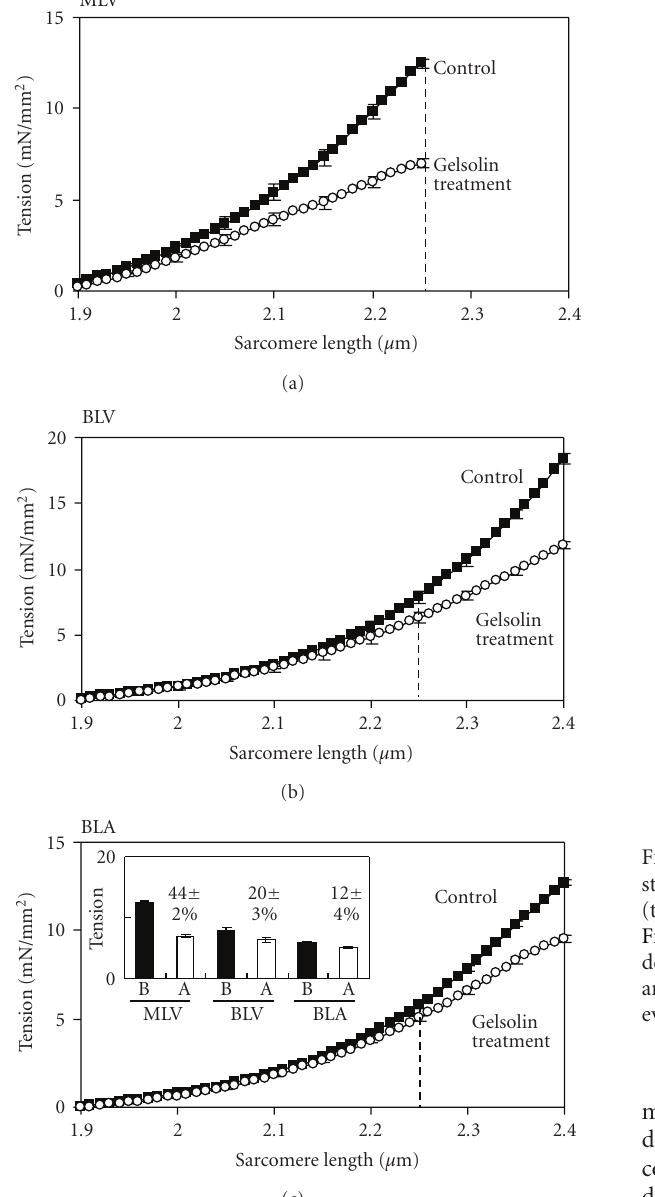
Figure 2: Measurements of titin-based passive tension, before and after gelsolin treatment. (a)–(c) In MLV, BLV, and BLA titin-based passive tension is reduced following gelsolin treatment. At a SL of 2.25 μ m. Decrease in titin-based passive tension is largest in MLV, smallest in BLA, with BLV being intermediate. Data are based on Figure 1; see text for details. Error bars are SE (for clarity plotted only every 0.05 μ m).